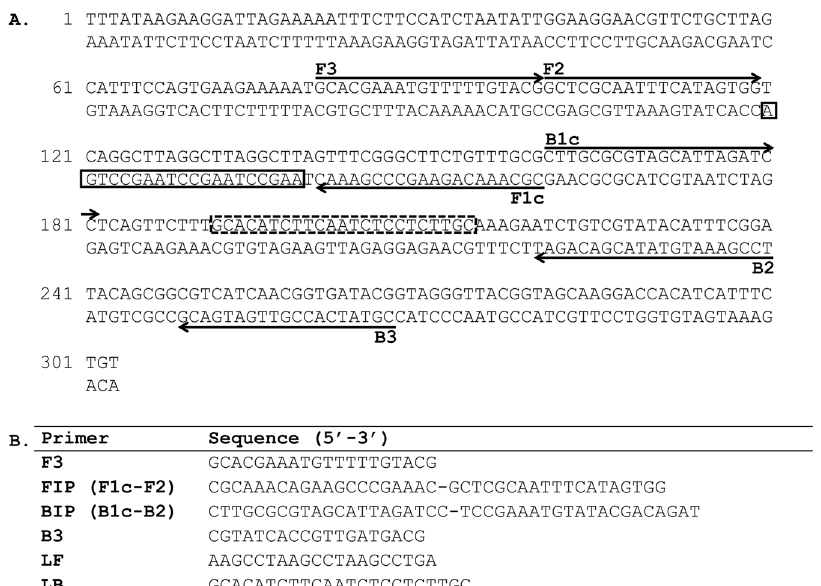
Figure 3. LAMP primer set targeting the M . ozzardi Mo2 repeat. ( A ) The location of the six LAMP primers within the consensus sequence is shown. Arrows indicate the direction of extension. The solid and dash line boxes represent the binding regions of the loop forward (LF) and loop back (LB) primers respectively. ( B ) Sequence of the LAMP primers.